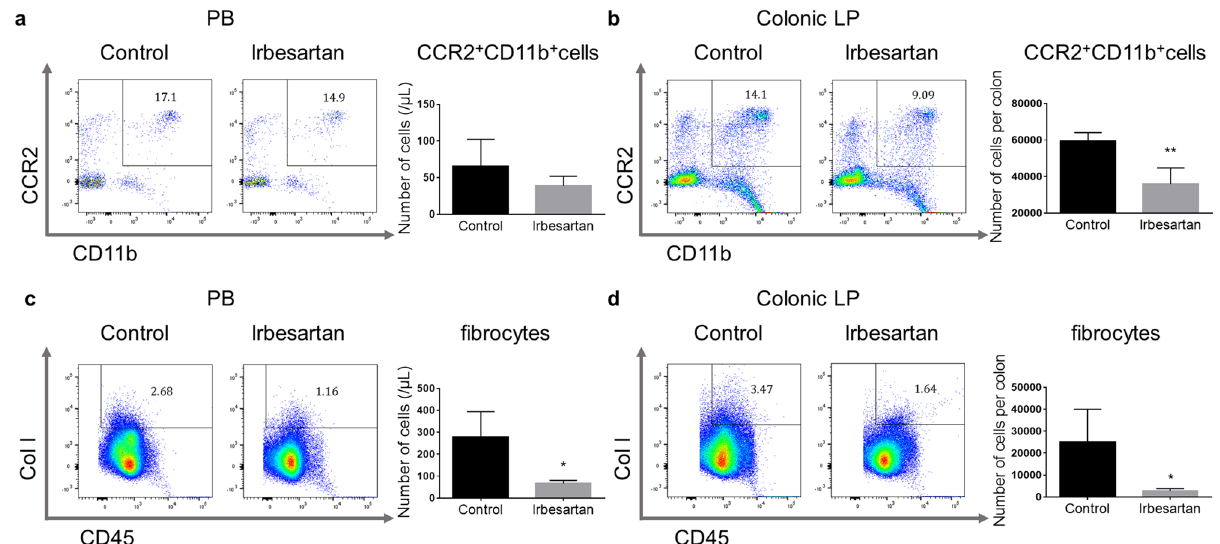
Figure 3. Reduction of CCR2 + CD11b + cells and CD45 + Col I + fibrocytes in the peripheral blood (PB) and colonic lamina propria (LP) by irbesartan. ( a , b ) Representative dot plots of CCR2 + CD11b + cells in PB and colonic LP obtained from control and irbesartan-treated mice. Quantification of CCR2 + CD11b + cells as absolute numbers for each mouse group. ( c , d ) Representative dot plots of CD45 + Col I + fibrocytes in PB and colonic LP obtained from control and irbesartan-treated mice. Quantification of CD45 + Col I + fibrocytes as absolute numbers for each mouse group. Data are presented as mean ± SD (control mice, n = 4, and irbesartan-treated mice, n = 4). *P < 0.05 and **P < 0.01 versus control mice. CCR2, CC chemokine receptor 2; Col I, type 1